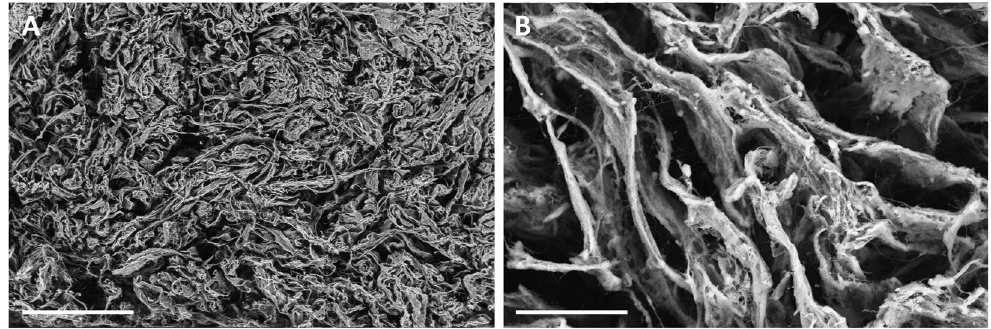
Figure 1. SEM images of the scaffold internal structure at two different magnifications. At higher magnification, an open and interconnected porosity is visible within the bone-like scaffold and Mg-HA particles are visible within and on the surface of the collagen fibers ( B ). Magnification: 30 × in A; 300 × in B. Scale bars: 1000 µ m in ( A ) 100 µ m in ( B